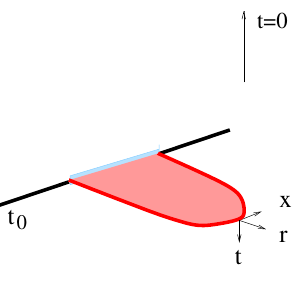
Figure 2 . Cartoon of the local geometry of the extremal surface near the turning point ( r ∗ , t ∗ ) . The surface is anchored on a time slice t far from the singularity at t = 0 (not shown). It dips in 0 the direction away from the